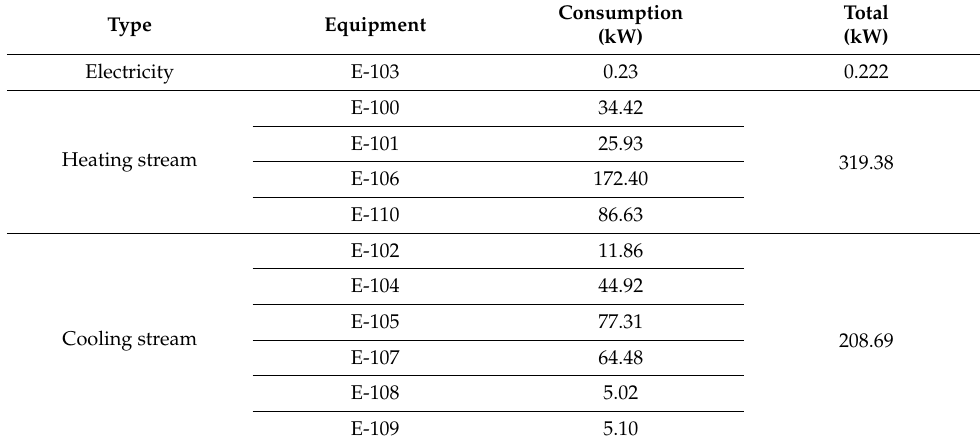
Figure 6. Energy balance concept for the process simulation. Table 6. Utility requirement in the production of biodiesel from 1100 L/h RSO.